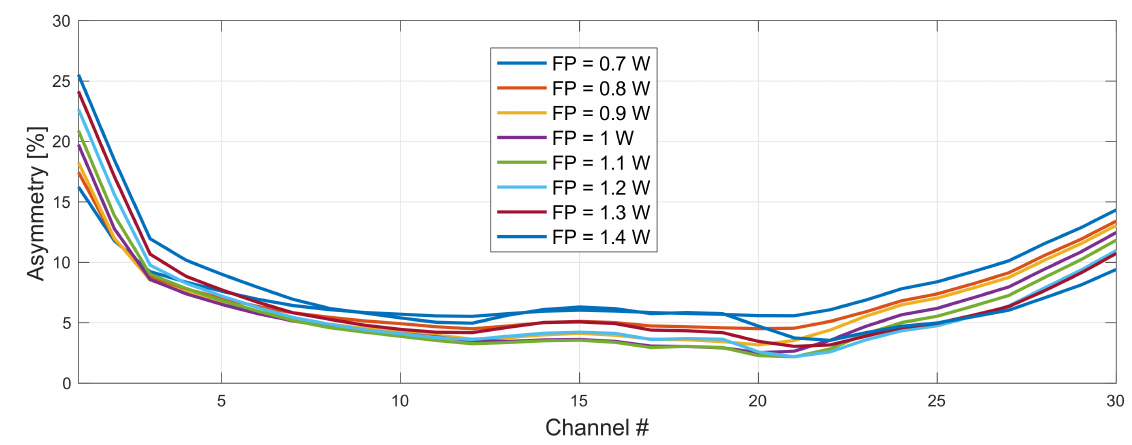
Figure 9. Impact of pump power choice (original WDM grid) on asymmetry performance. Forward pump power of the conjugated grid was fixed to be 1.3 W. FBG for original and conjugated WDM grid was set to 1460 and 1450 nm,